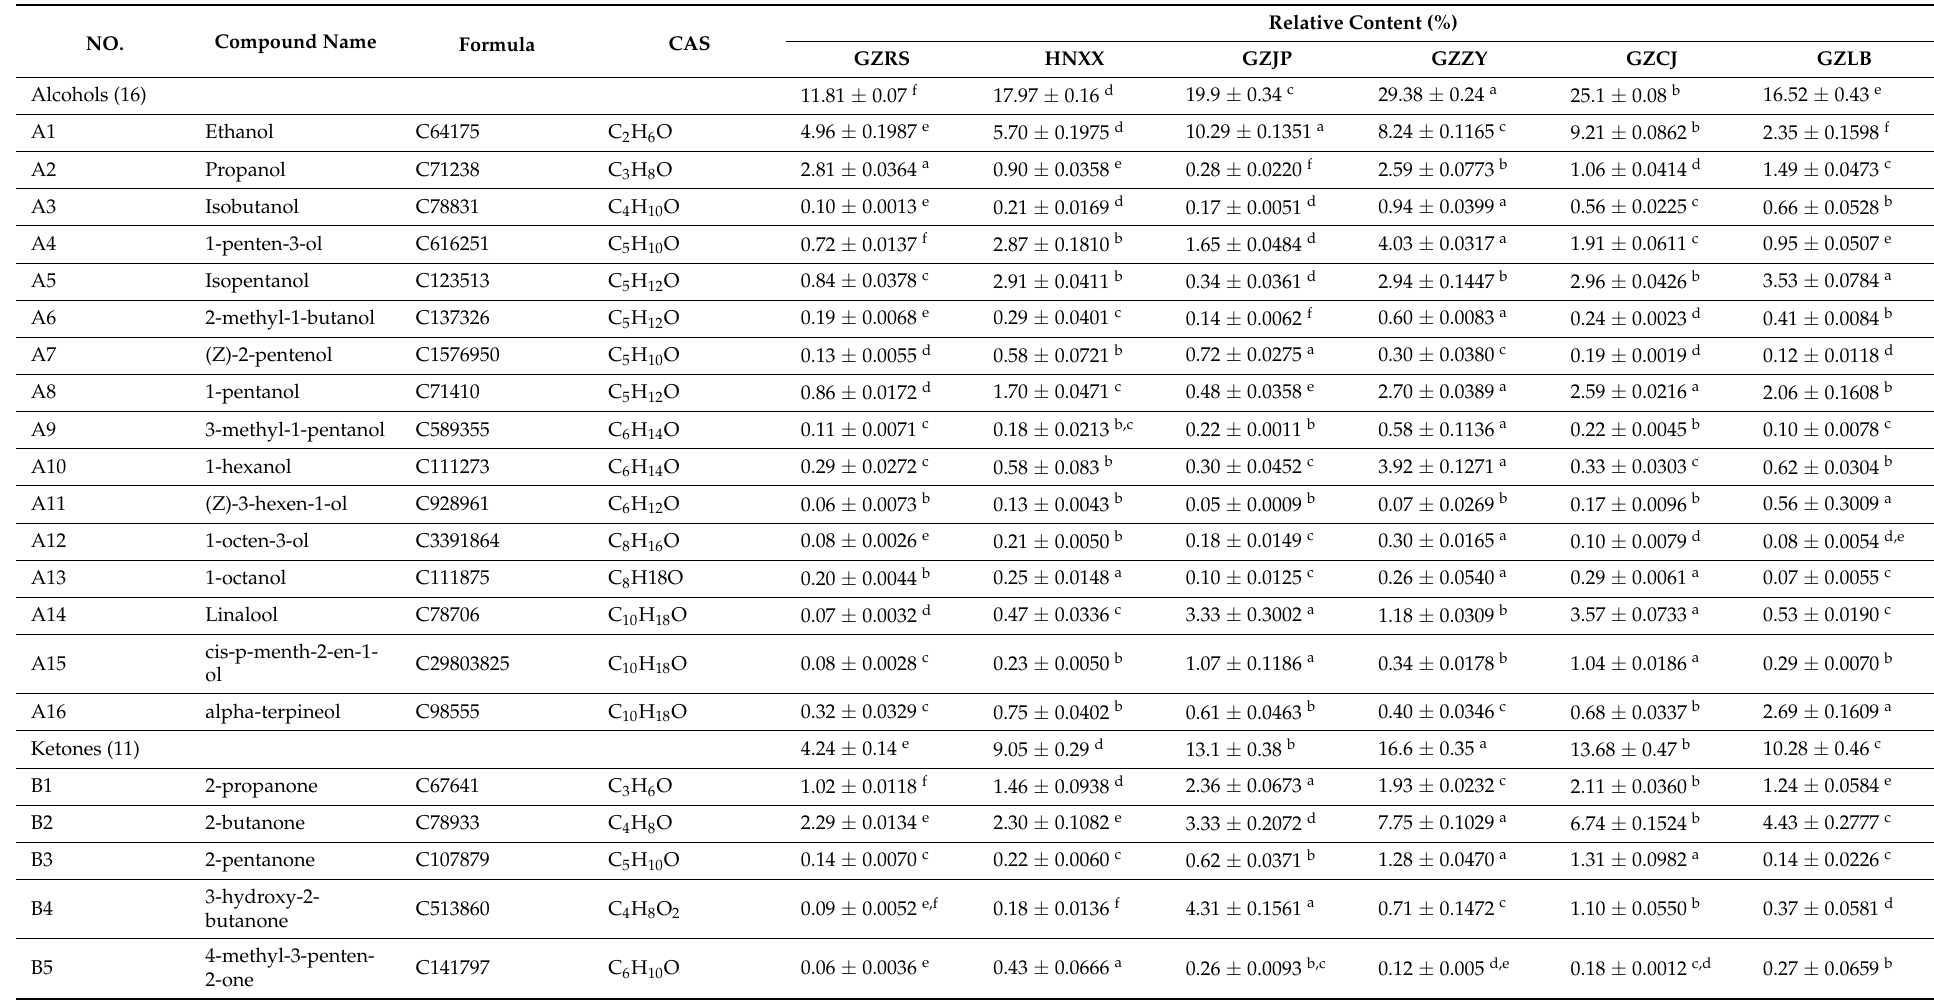
Table 4. GC-IMS detected volatiles of SR from different